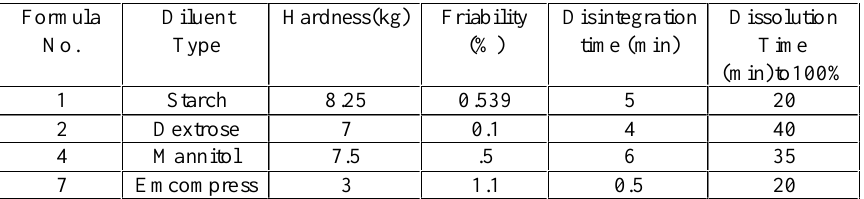
Effect of Diluent on the Physical Properties of Orphenadrine Citrate Plain Tablets